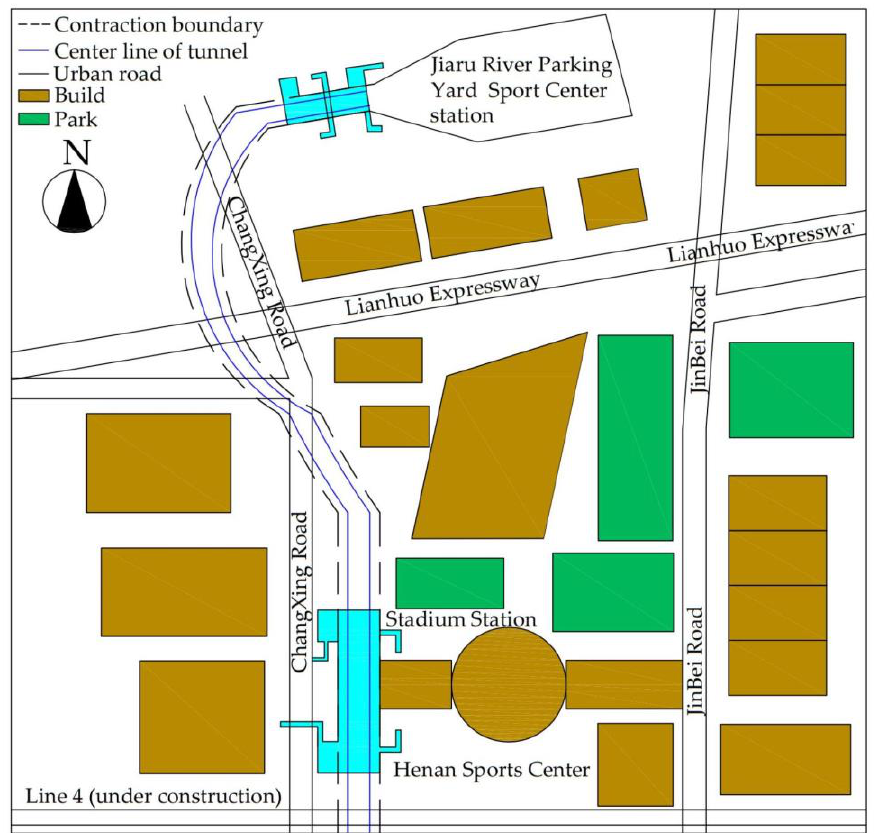
Figure 1. Location of the small radius curved shield tunnel of Jiaru River Parking Yard entry line of Zhengzhou Metro Line 3.